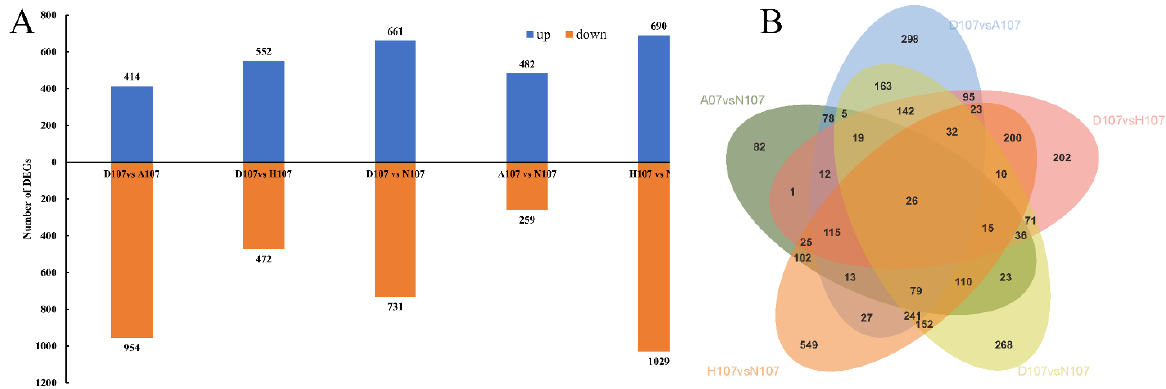
Figure 3. Number of DEGs under hypoxia and acidification stress in L. crocea depicted using ( A ) a histogram and ( B ) a Venn diagram.